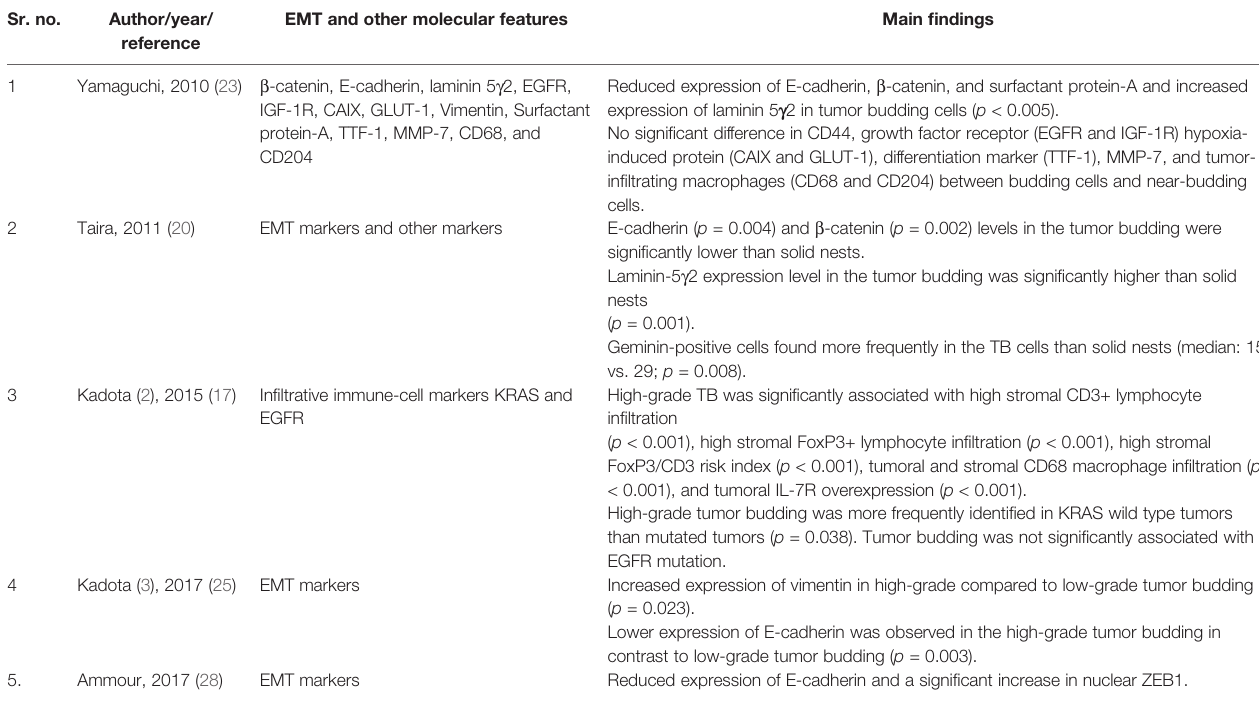
TABLE 2 | Summary of included studies that evaluate the epithelial – mesenchymal transition and immune cell markers with tumor budding in lung cancer. Sr.